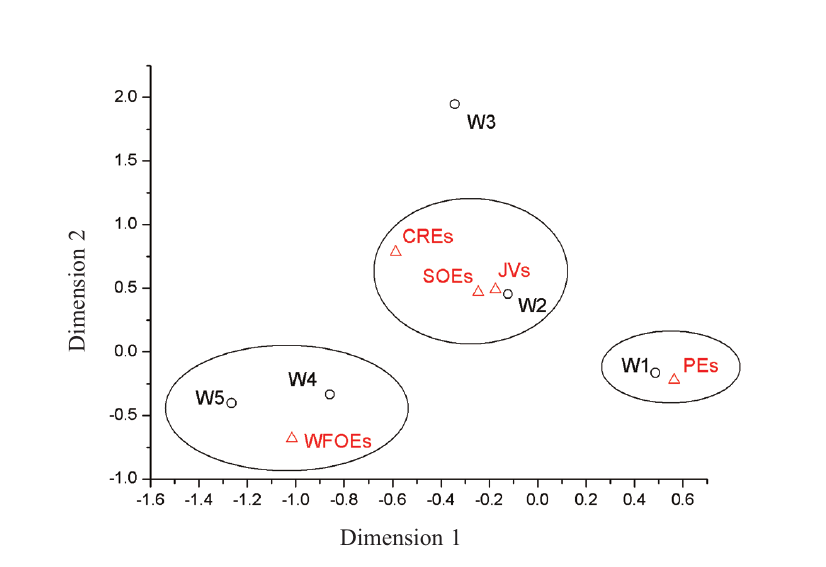
Fig. 2. Positioning maps between firms’ ownership and internationalized paths